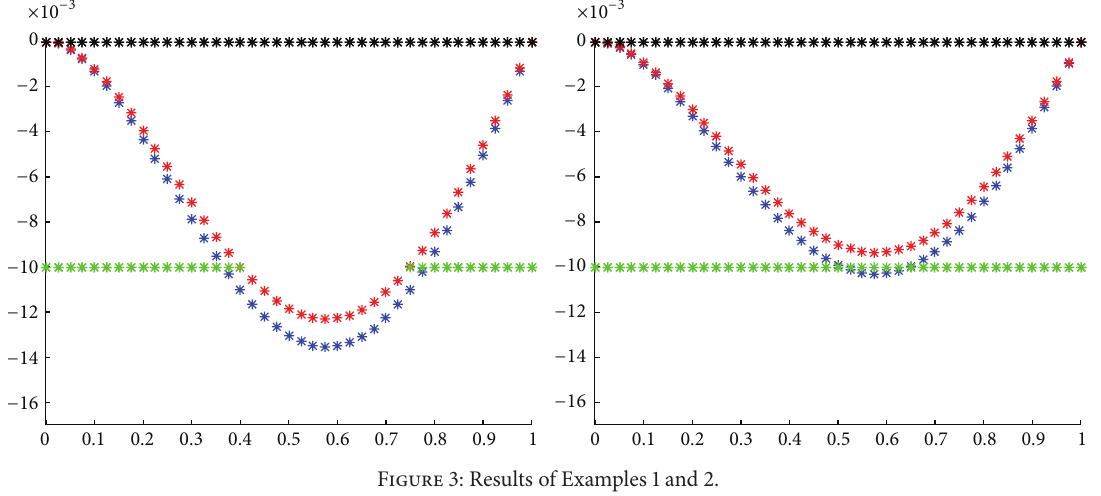
Figure 3: Results of Examples 1 and